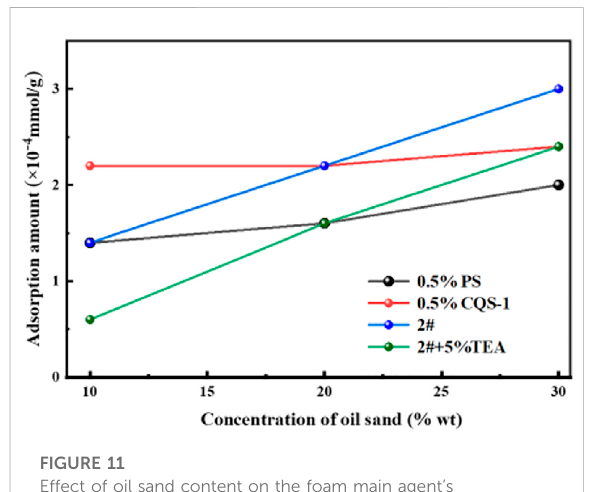
FIGURE 11 Effect of oil sand content on the foam main agent ’ s adsorption at the core surface.